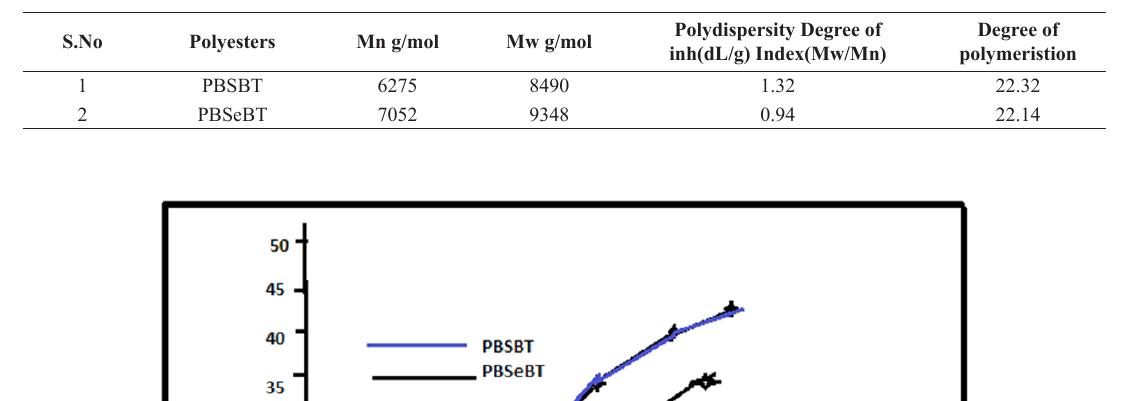
Table.4: Thermal transition temperatures of the synthesized polyesters